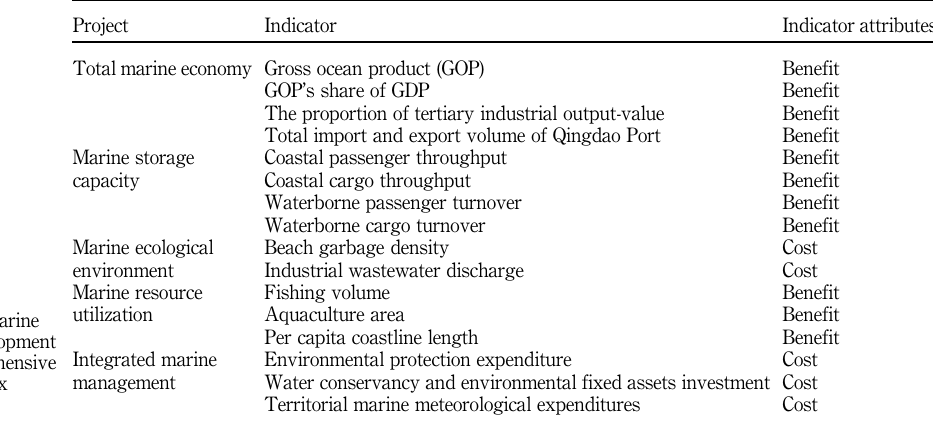
Table I. Qingdao city marine economic development quality comprehensive evaluation index